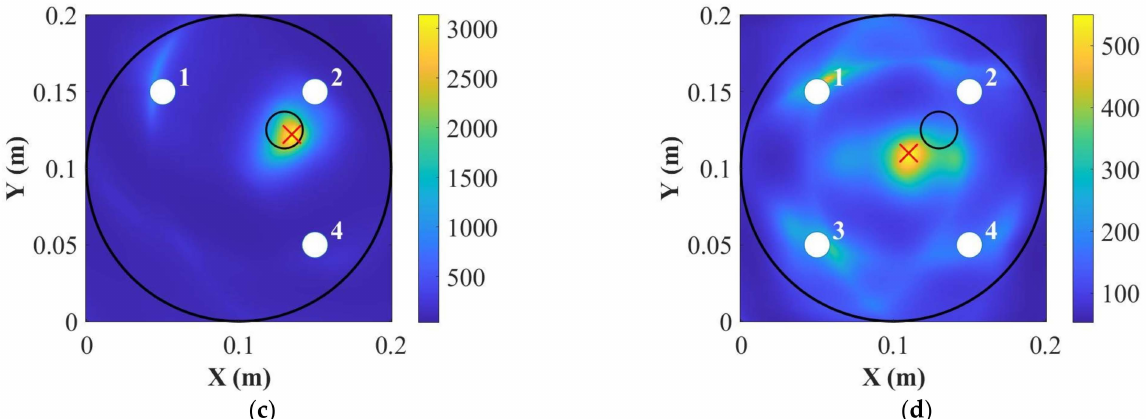
Figure 6. Delamination detection using ( a ) three PZT transducers and ( b ) four PZT transducers, and localization using ( c ) three PZT transducers and ( d ) four PZT transducers at 250 kHz for the position 2 (where the “ ” is the position for real damage and the “ × ” is the position for predicted damage). (cid:35)